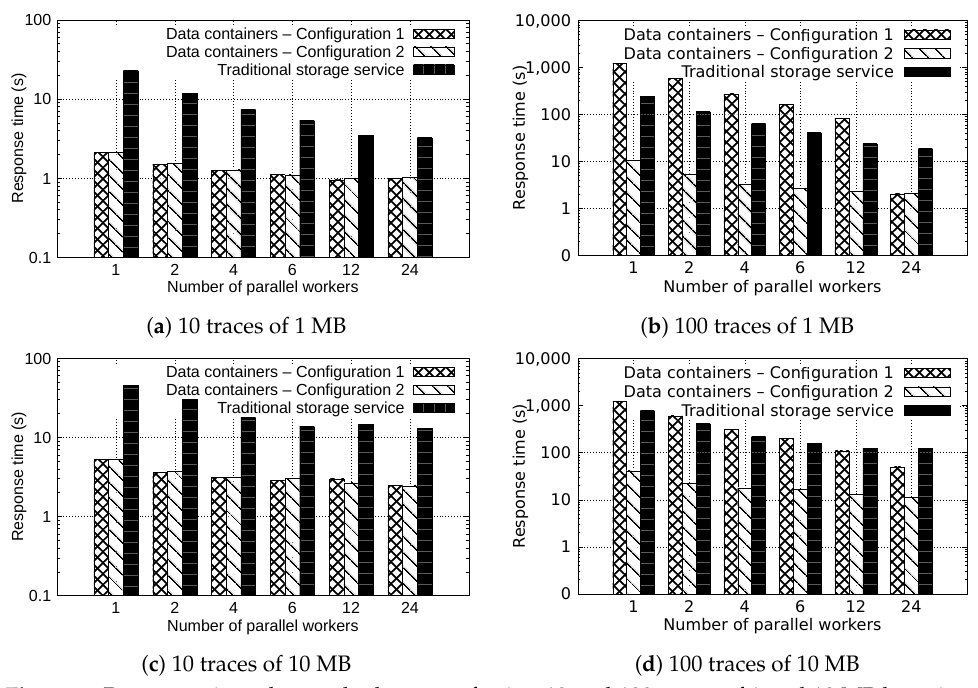
Figure 5. Response time observed when transferring 10 and 100 traces of 1 and 10 MB by using a varying number of parallel